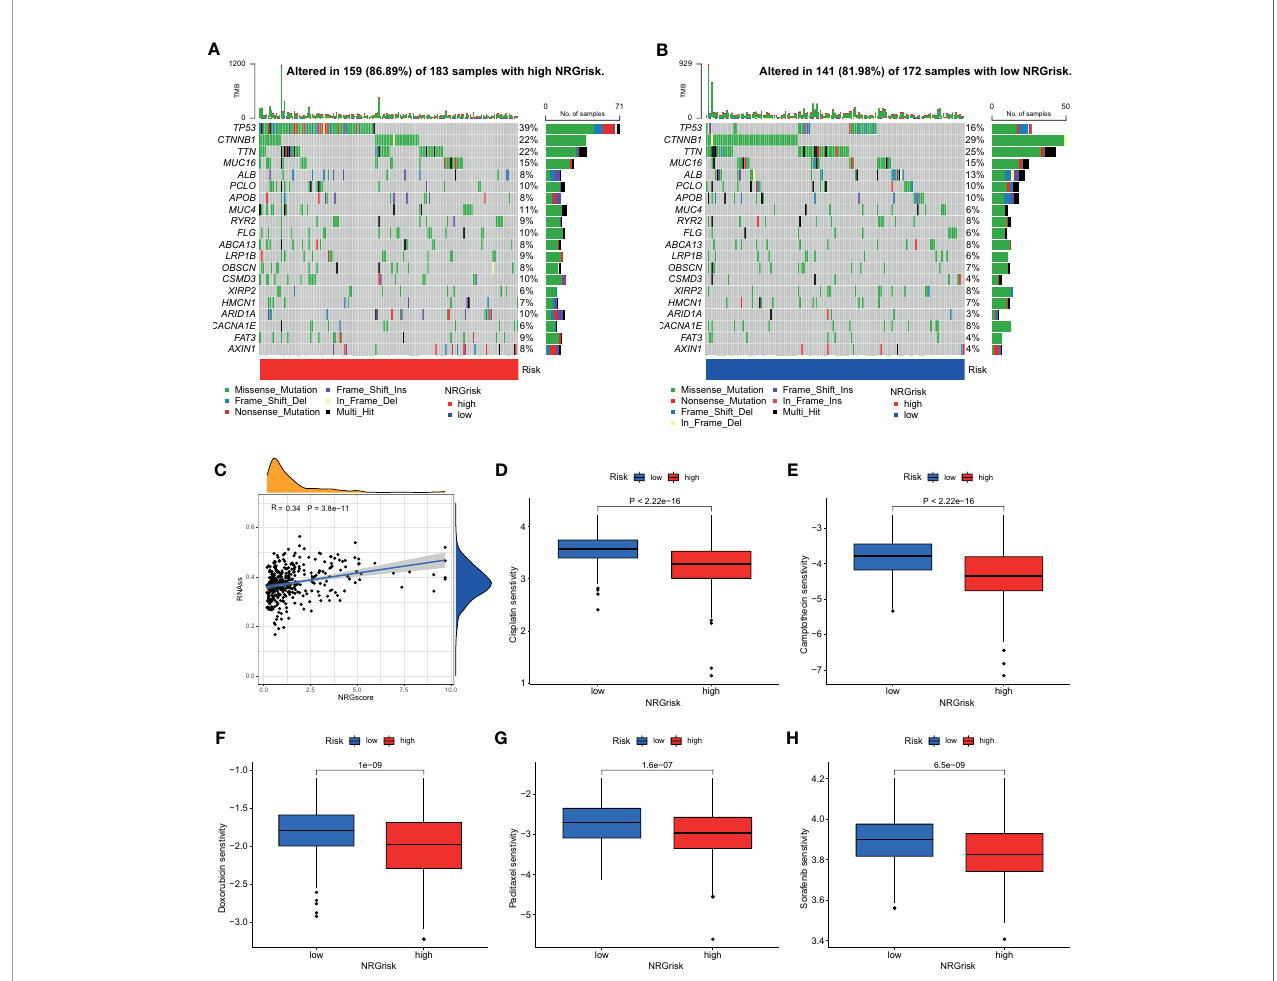
FIGURE 7 | Characteristics of NRGscore with tumor somatic mutation, stem cell, and chemotherapy sensitivity. (A, B) The waterfall plot of tumor somatic mutation was drawn in those with high NRGrisk group (A) and low NRGrisk (B) respectively. Each column indicated individual HCC patients, and the upper bar diagram exhibited TMB. The right number represented the mutation frequency, and the bar diagram on the right exhibited the proportion of each variant type, including missense, nonsense, splice, frameshift, and multiple mutations. (C) Correlation between NRGscore and component of stem cell. (D-H) Box diagrams showed the chemotherapy response between high NRGrisk and low NRGrisk groups: (D) Cisplatin, (E) Camptothecin, (F) Doxorubicin, (G) Paclitaxel, (H) Sorafenib. NRGscore, necroptosis-related gene score; NRGrisk, necroptosis-related gene risk; HCC, hepatocellular carcinoma; TMB, tumor mutation burden; IC50, half-maximal inhibitory